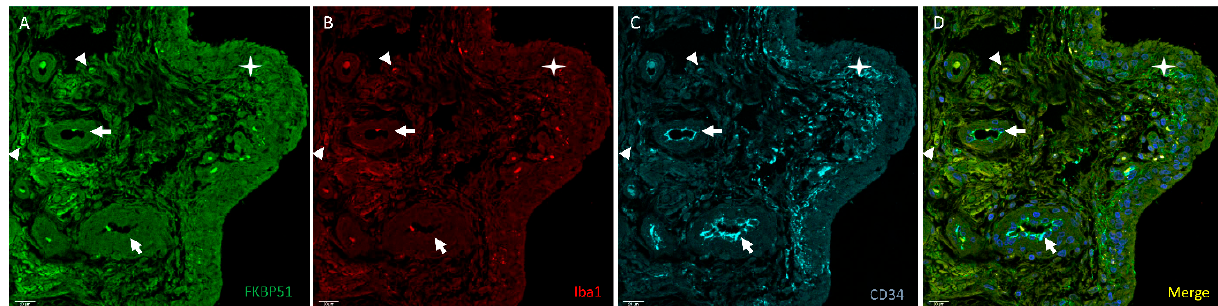
Figure 8. Representative images of triple immunolabelling for FKBP51 (panel A ), Iba1 (panel B ) and CD34 (panel C ) in suprapatellar synovial tissue from a patient with knee OA (grade IV). FKBP51+/Iba+ cytosolic (arrowheads). CD34+ staining was observed in vessels (arrows). The star is placed in the proliferated synovial membrane with several layers of cells. Most cells in the deeper layer are CD34+. Panel D shows the merge image of FKBP51, Iba1 and CD34 immunolabelling.